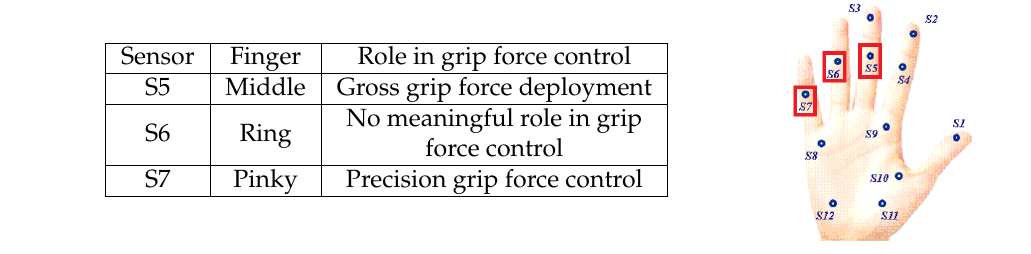
Figure 8. Three functionally representative sensors [17].